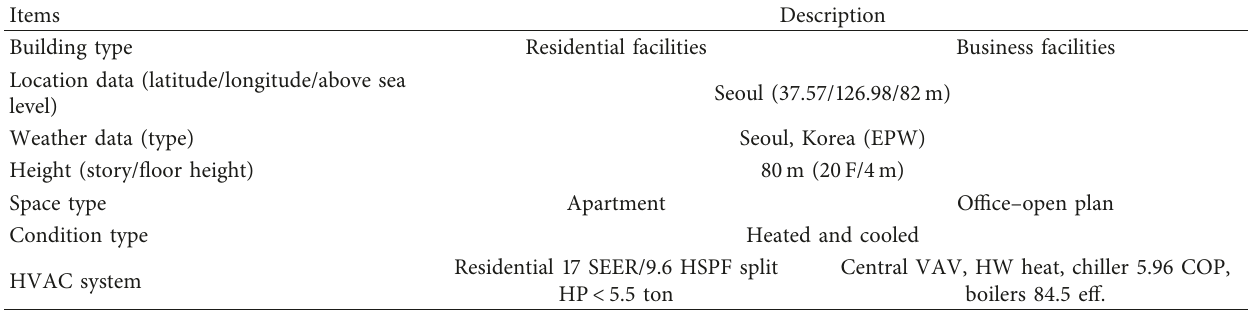
Table 2: Building summary.